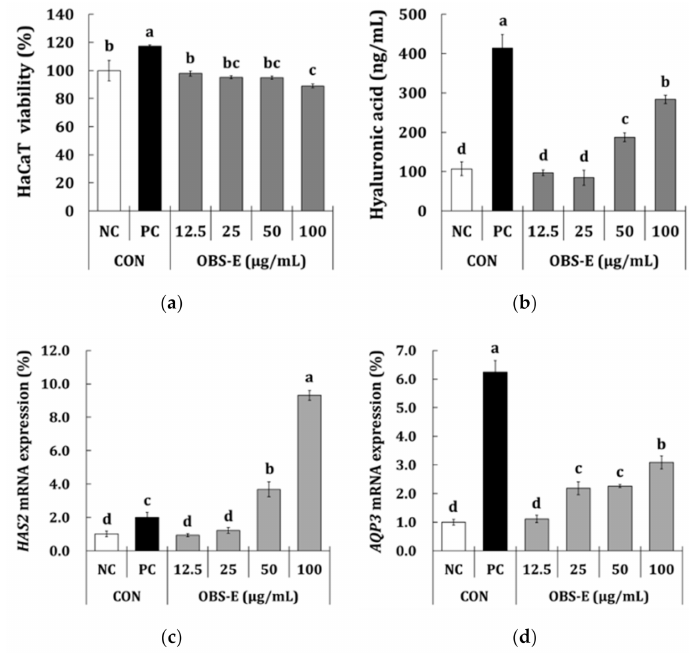
Figure 2. Skin-moisturizing activity of OBS-E in human keratinocytes (HaCaT). ( a ) Cell viability, ( b ) hyaluronic acid production, ( c ) HAS2 mRNA expression, ( d ) AQP3 mRNA expression. Medium and N -acetylglucosamine (5000 µ g/mL) were used as a negative control (NC) and a positive con- trol (PC), respectively. The different superscripts indicate significant differences among groups as analyzed using the Tukey’s t -test ( p < 0.05). HAS2 , hyaluronic acid synthase-2; AQP3 ,